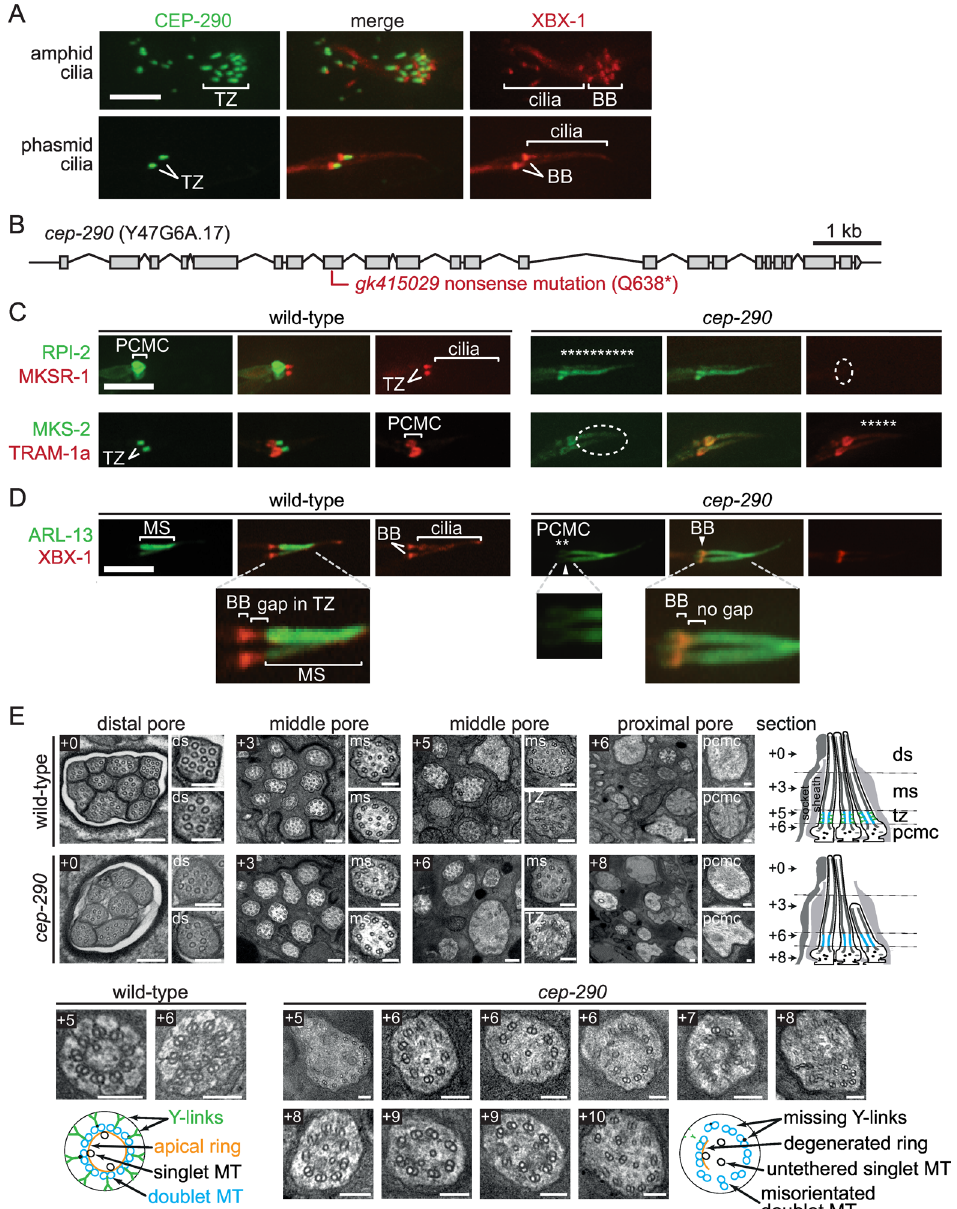
Fig 3. C . elegans CEP-290 is a transition zone protein required for ciliary gate (membrane diffusion barrier) function and transition zone assembly. ( A ) C . elegans CEP-290 (Y47G6A.17) tagged with GFP (green) is expressed only in ciliated sensory neurons (including amphids and phasmids) and is specifically enriched at the ciliary transition zone (TZ). tdTomato-tagged XBX-1 (red) is an IFT protein that marks the basal body (BB) and axoneme. Scale bars in panels A, C, and D are 4 μ m. ( B ) cep-290 gene structure and likely null allele ( gk415029 nonsense mutation) isolated from the Million Mutation Project (MMP) mutant strain VC30108. ( C ) CEP-290 is required for maintaining the functional integrity of the TZ. Two membrane-associated proteins (TRAM-1a:: tdTomato and RPI-2::GFP) normally present at the base of cilia and not present within cilia show abnormal ciliary entry ( “ leakage ” ) or accumulation in the cep-290 mutant (shown as asterisks). MKSR-1::tdTomato and MKS-2::GFP are TZ protein comarkers (in wild-type) that mislocalise in the cep-290 mutant (dotted ellipse). ( D ) CEP-290 is required to exclude membrane-associated GFP-tagged ARL-13 (green) from the transition zone and compartmentalise it within the ciliary middle segment (MS), consistent with a role for CEP-290 in TZ gate function. In the cep-290 mutant, ARL-13 is also seen outside of the cilium in the periciliary membrane compartment (PCMC) region (mislocalisation shown with asterisks). ( E ) Transition zone ultrastructure is missing in cep- 290 mutants. Transmission electron microscopy images from serial cross-sections of the amphid channel (pore) in wild-type and cep-290 mutant worms. Boxed numbers denote positioning of sections relative to anterior-most section (+0); section positions also shown in schematics on right-hand side. Wild-type amphid channels possess ten ciliary axonemes, each with distal segment (ds; outer singlet A-tubules), middle segment (ms; outer doublet A/B tubules), and transition zone (TZ; outer doublet A/B tubules, Y-links, apical ring) compartments. In cep-290 mutants, one to two cilia are missing from the distal pore, indicating that one to two axonemes are short. TZ ultrastructure is severely disrupted in cep-290 worms; most or all Y-link structure is missing, as is the apical